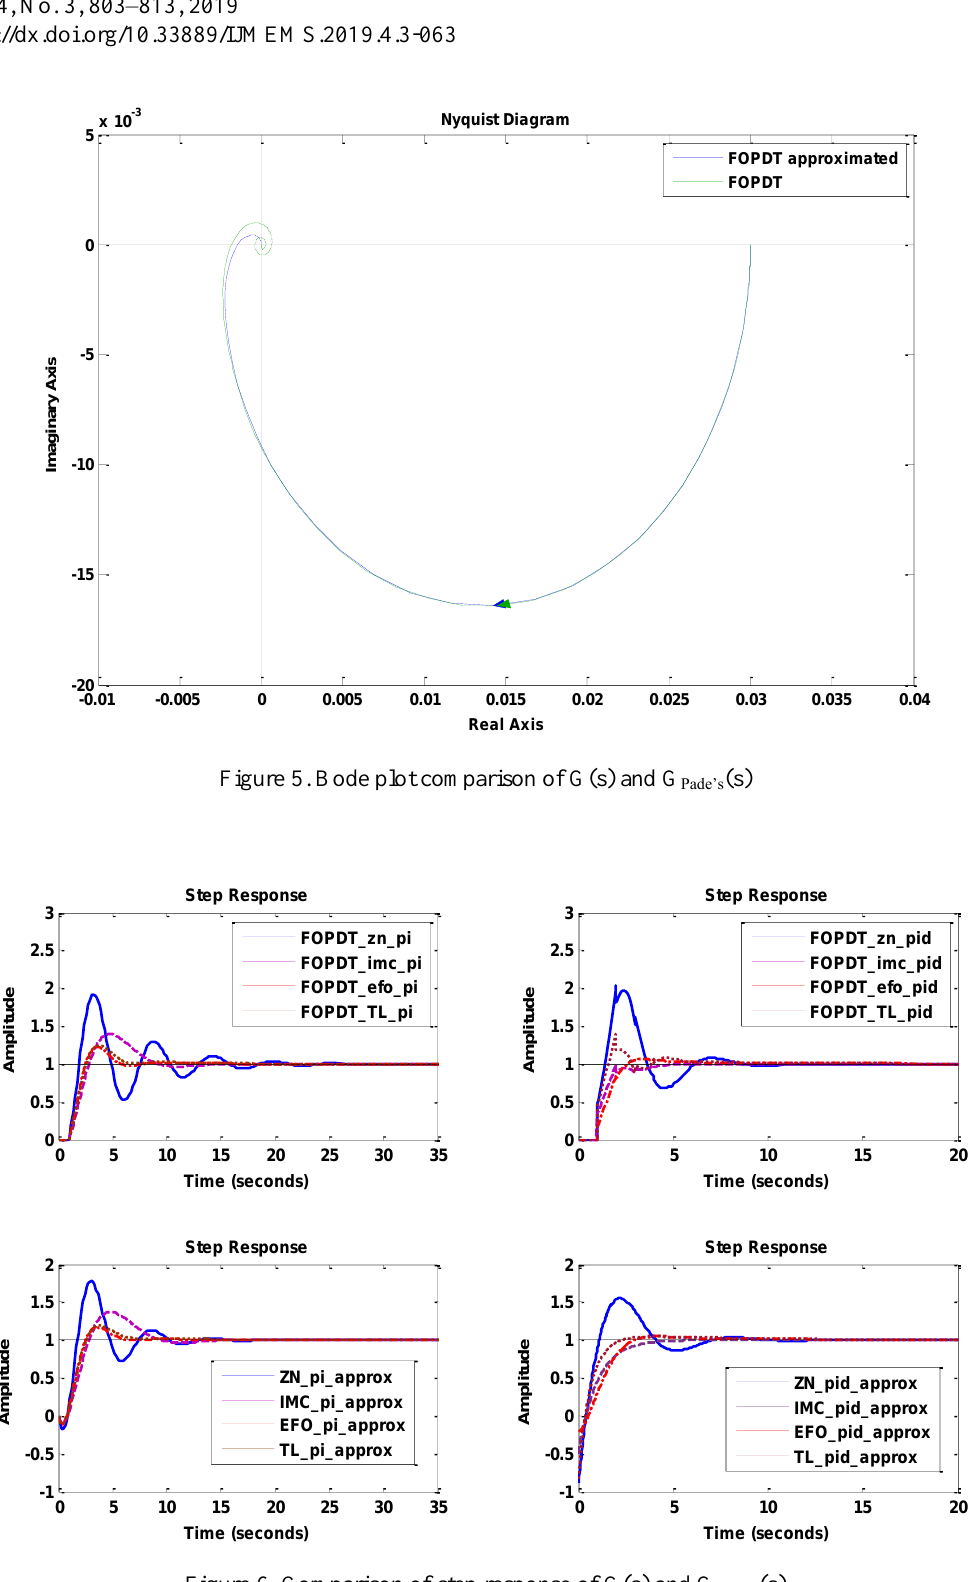
Figure 6. Comparison of step response of G(s) and G Pade’s